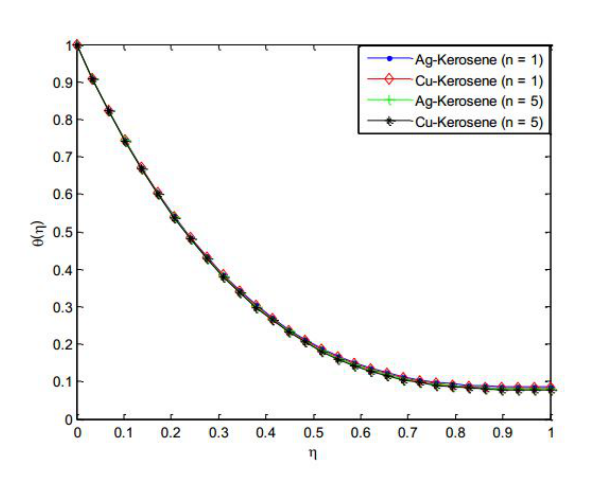
Figure 15. Effect of power-law index on the fluid temperature